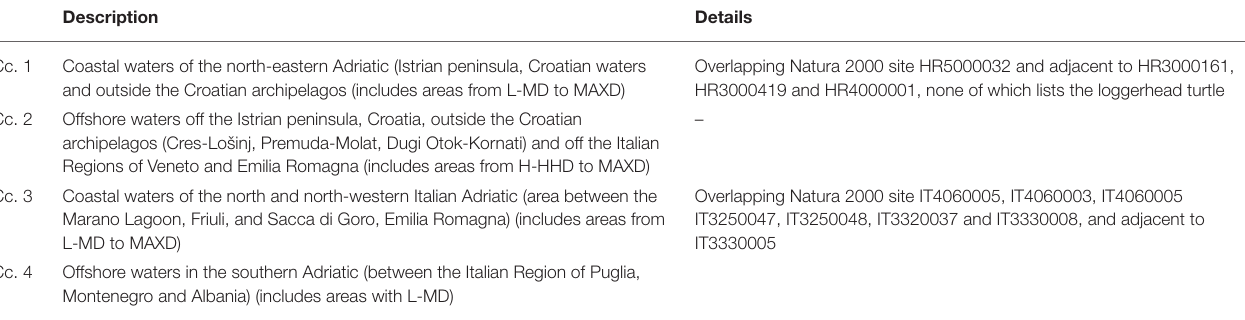
TABLE 4 | Proposed key areas for loggerhead turtles in the Adriatic Sea based upon the combined 2010, and 2013 datasets (see Figure 2